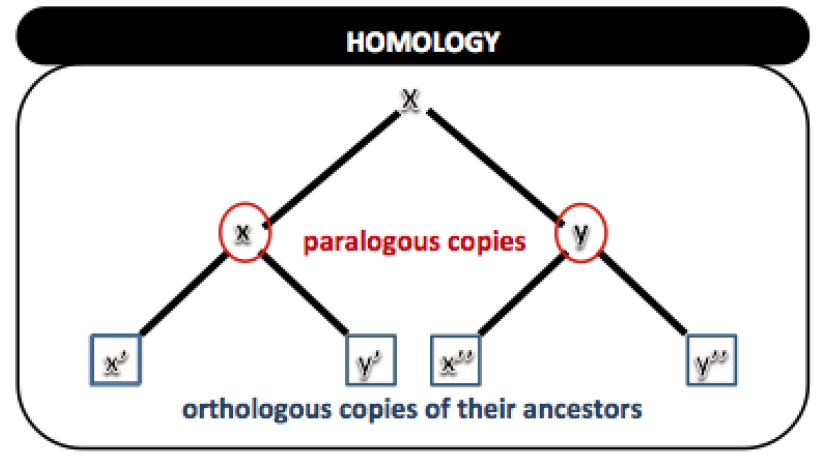
Figure 17. Homology